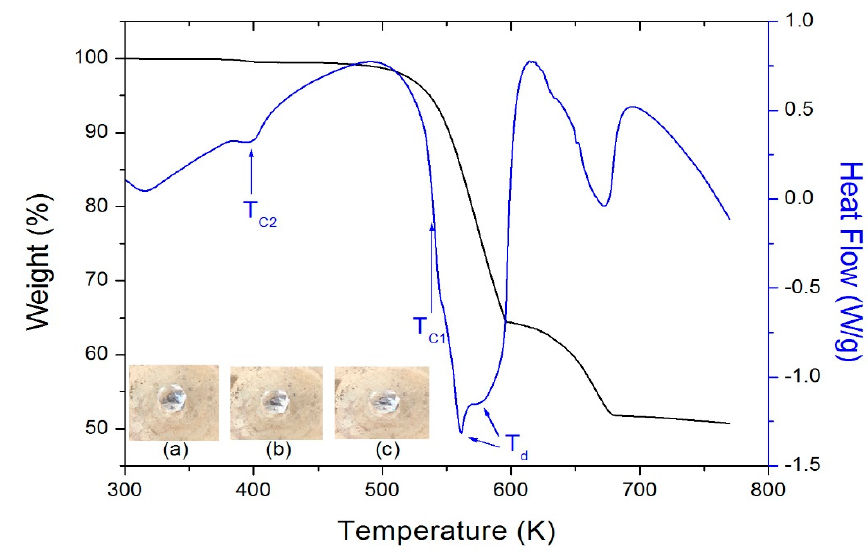
Figure 2. TGA and DSC curves of (C 3 H 7 NH 3 ) 2 CdCl 4 crystals. Insets show color of the crystal at ( a ) 293 K, ( b ) 393 K, and ( c ) 473 K.